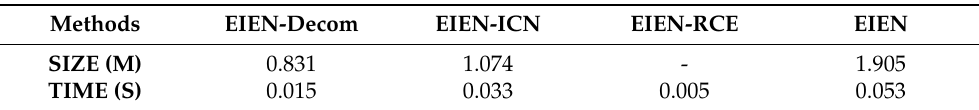
Table 2. SSIM results for different algorithms. The best result is in red whereas the second best one is in blue.